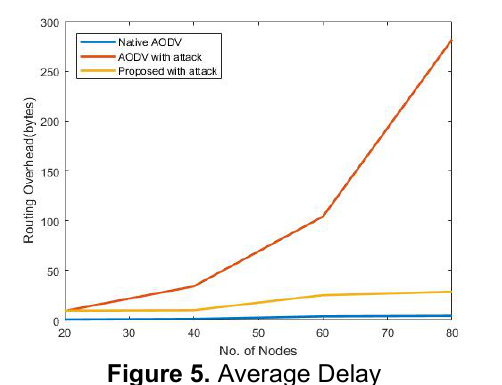
Figure 5. Average Delay